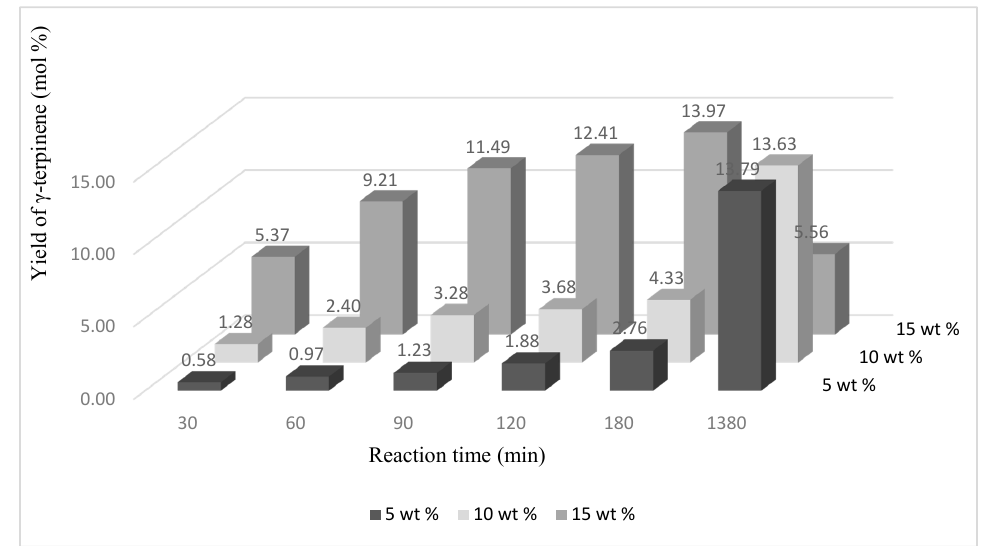
Figure 7. Influence of the amount of the catalyst and the reaction time on the yield of γ -terpinene, for the reaction carried out at 160 °C. The amount of the catalyst was 5, 10, or 15 wt %, and the reaction time was 30, 60, 90, 120, 180, or 1380 min. Catalysts 2017 , 7 , 273